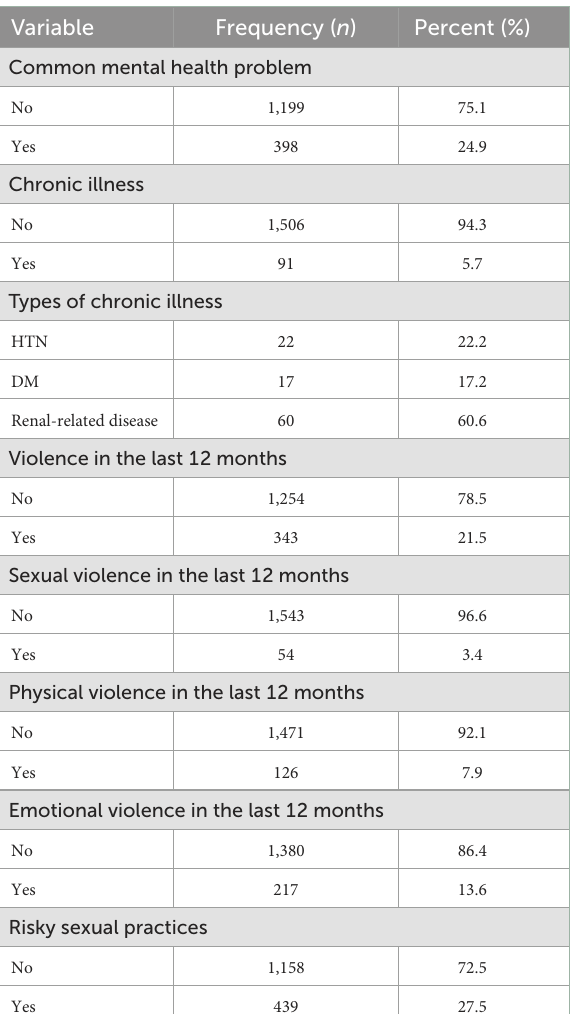
TABLE 3 Substance use characteristics of youths living in the central, west, and north Gondar zones.